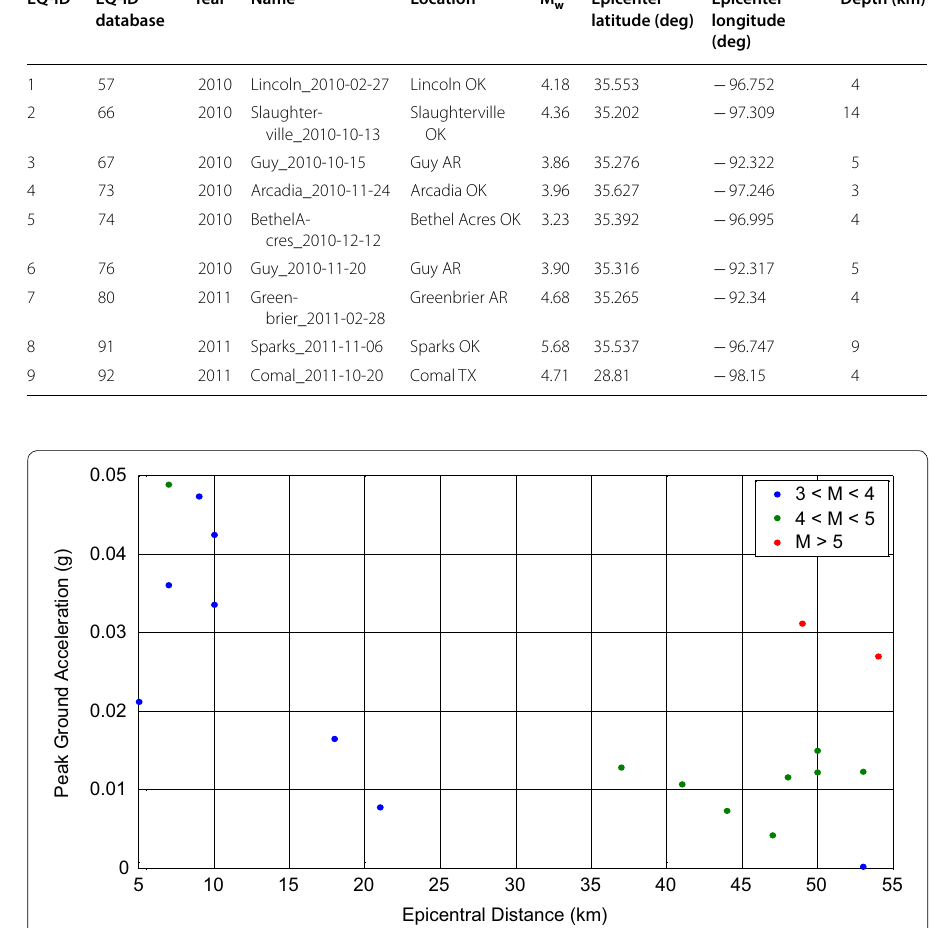
Table 1 Earthquake events involving induced seismicity identified in the PEER database EQ‑ID EQ‑ID database